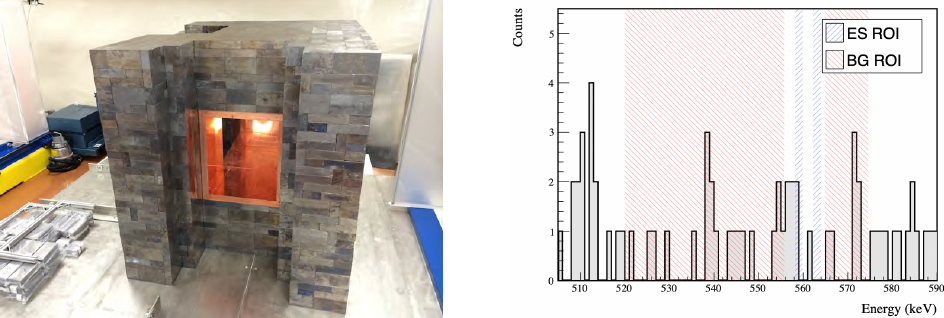
Figure 13. ( left ) Picture of the shield of MJD. It is possible to see the lead bricks and the inner copper shield (taken from Reference [96]). ( right ) MAJORANA measured energy spectrum after applying all the cuts (black histogram); the signal (ES=excited state) for the 2 ν 2 β − decay of 76 Ge to the 0 + level of 76 Se is searched for in the energy region of the two expected gamma quanta: 559 keV and 563 keV. The background (BG) ROI where the background is evaluated is labelled too. Reprinted from Reference [97] under the terms of the Creative Commons Attribution 3.0